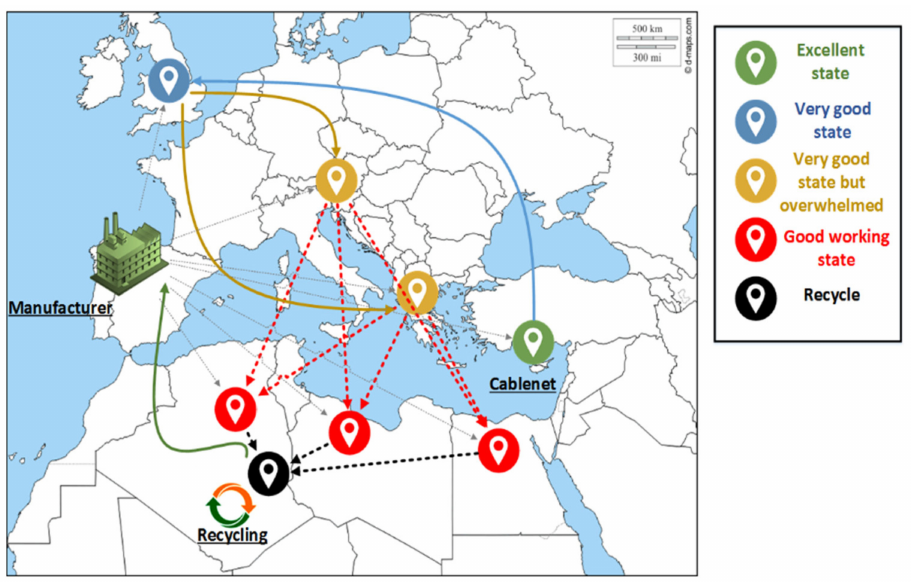
Figure 1. The CE-IoT emulated